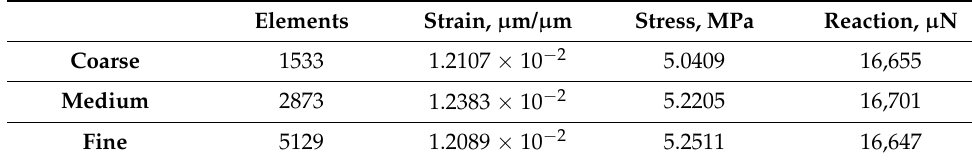
Table 3. The grid-independent verification.